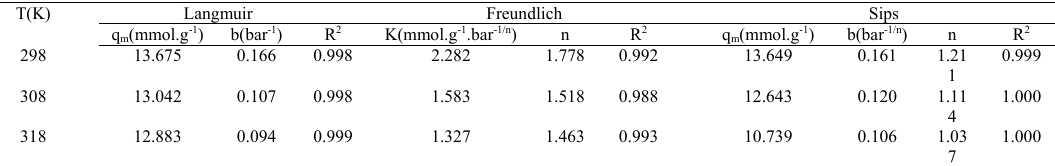
Table 2 The parameter values of the three isotherm equations. Table 2. The parameter values of the three isotherm